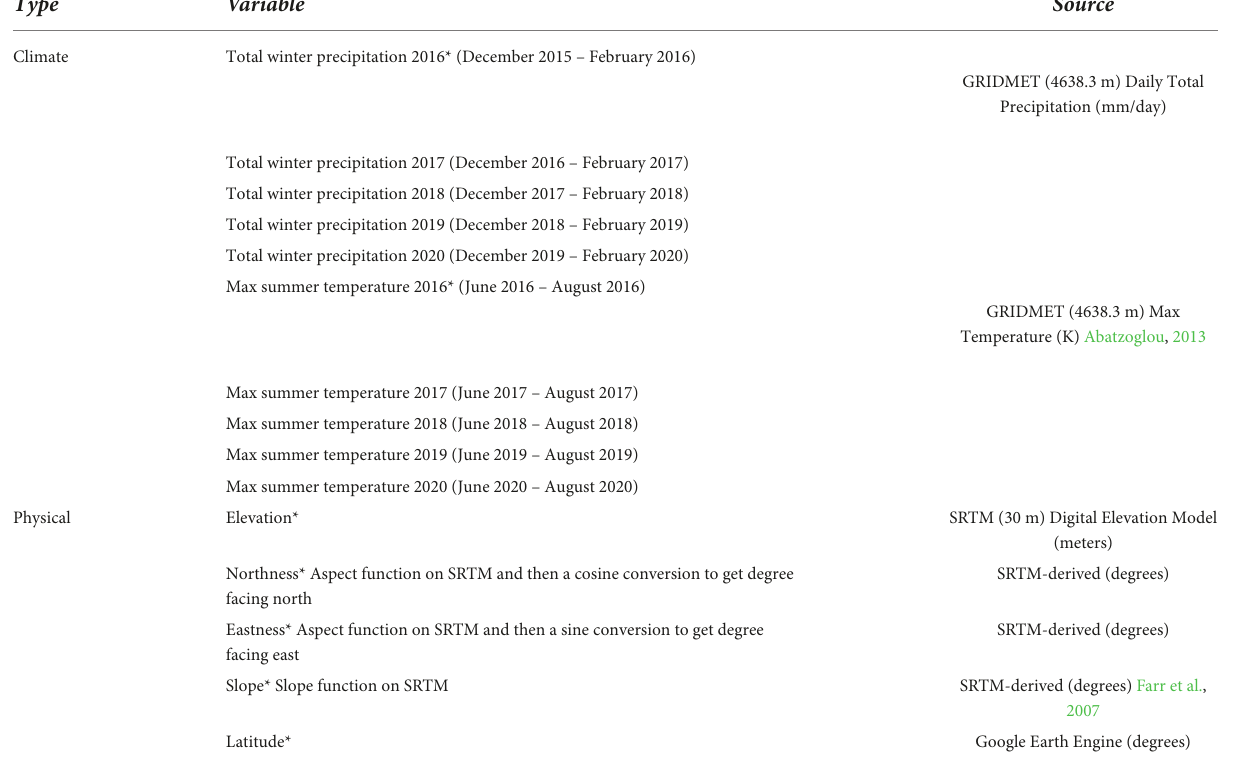
TABLE 1 List of biophysical variables used for propensity score matching, indicated with asterisk, and full list of variables included in linear